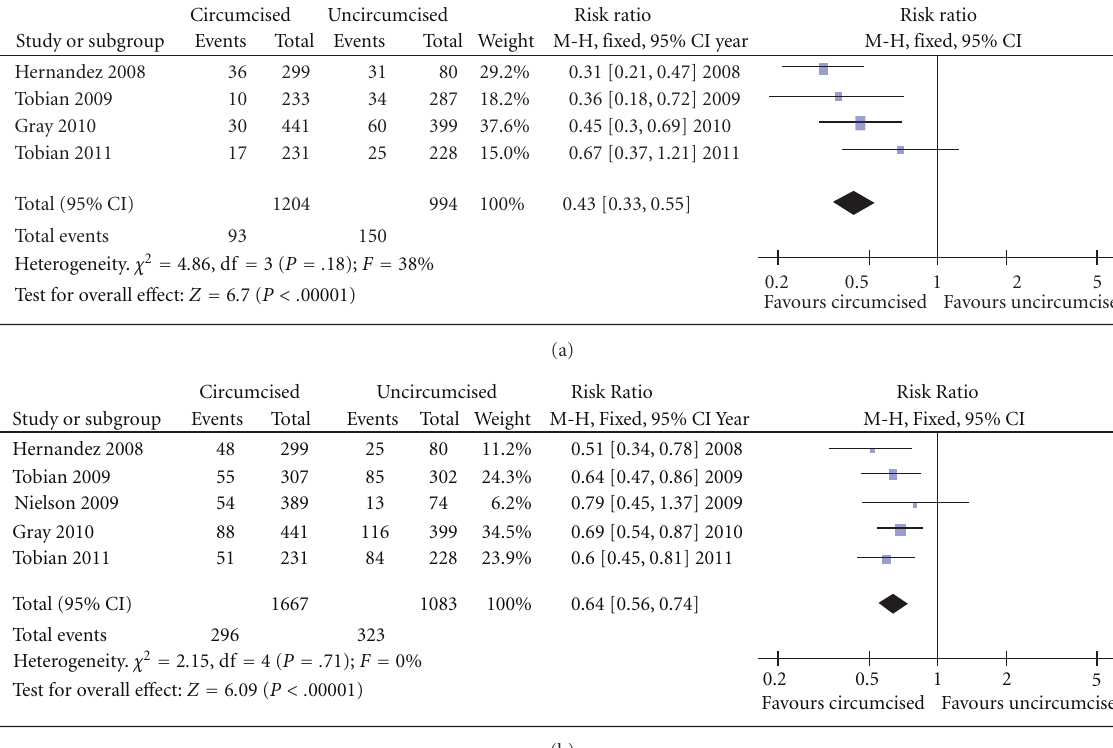
Figure 4: Fixed e ff ects forest plot models of the unadjusted risk ratios for (a) any high-risk HPV and for (b) multiple high-risk HPV infections detected at the coronal sulcus/glans in circumcised and uncircumcised men. The data are derived from both observational studies and randomized trials, and include HPV prevalence and incidence estimates. The unadjusted risk ratios di ff er from the adjusted odds ratios reported in some studies, because the odds ratio does not approximate to the risk ratio with common disease outcomes such as HPV, and because adjustment for risk behaviors may a ff ect estimates. Nevertheless, the findings are in general consistent across studies as indicated by the nonsignificant tests for heterogeneity and suggest that, in aggregate, circumcision may reduce any high-risk HPV infection by approximately 36%, and multiple high risk HPV infections by